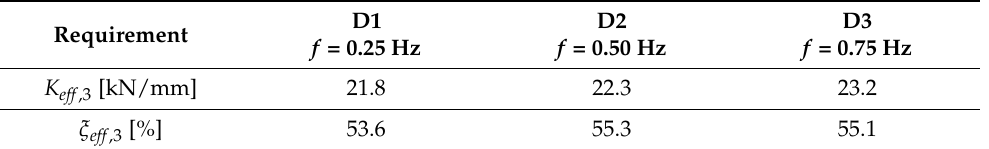
Table 3. Effect of velocity on the properties of the PS-LED prototype.